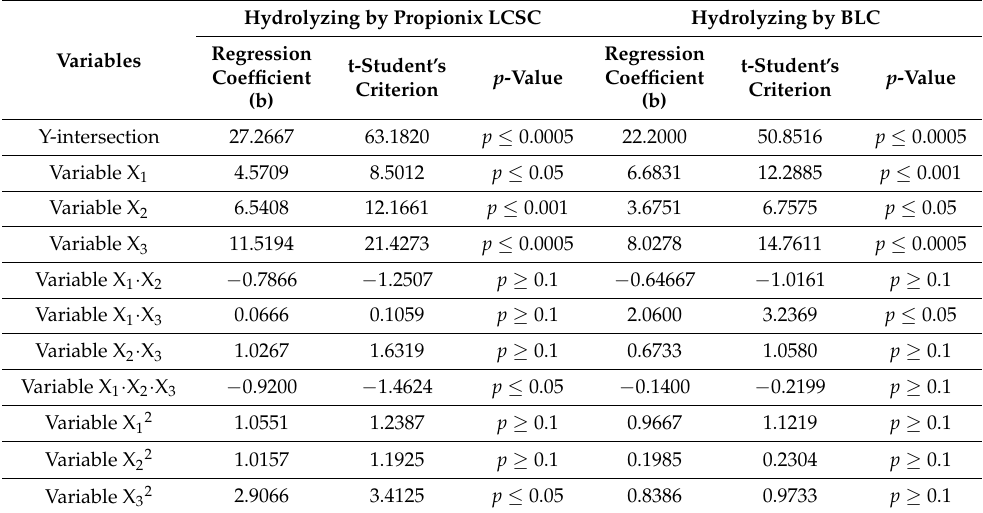
Table 3. Results of statistical analysis of data for variables (Xj) during hydrolysis of broiler chicken gizzards. Hydrolyzing by Propionix LCSC Hydrolyzing by BLC Regression Regression Variables t-Student’s p -Value Coefficient Criterion (b)